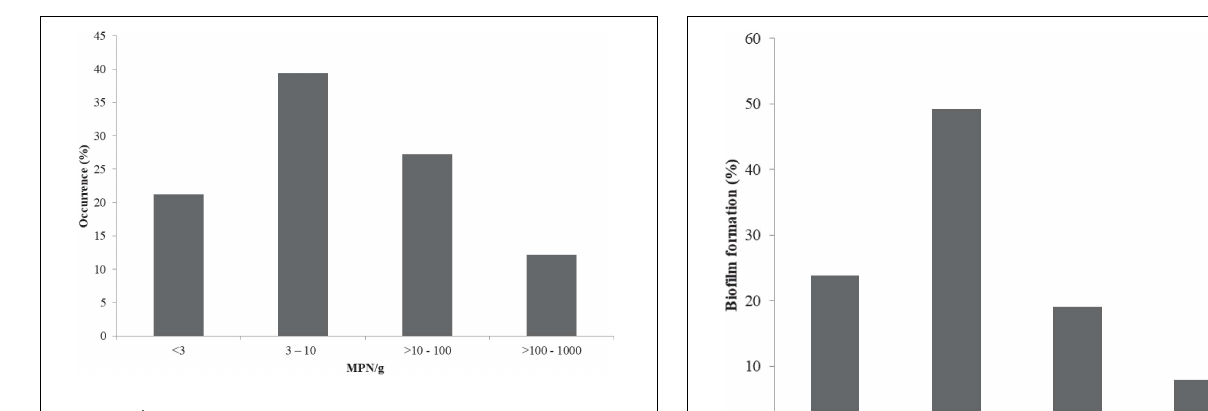
Frontiers in Microbiology |